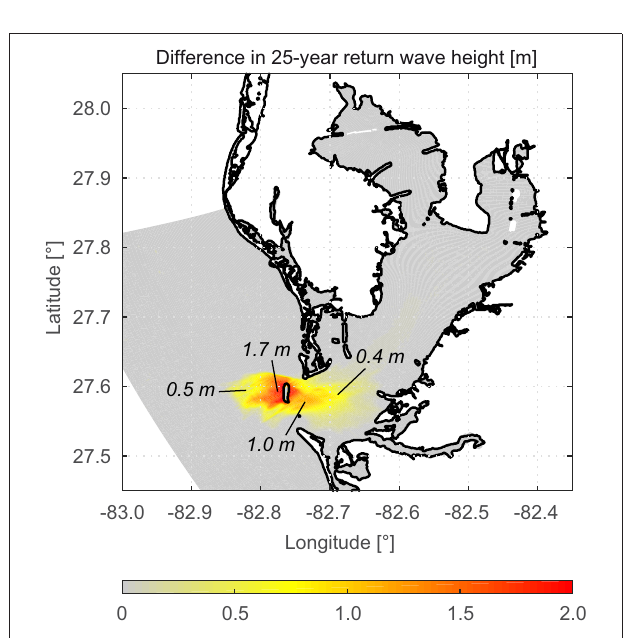
FIGURE 9 | Change in 25-year return wave height for all grid